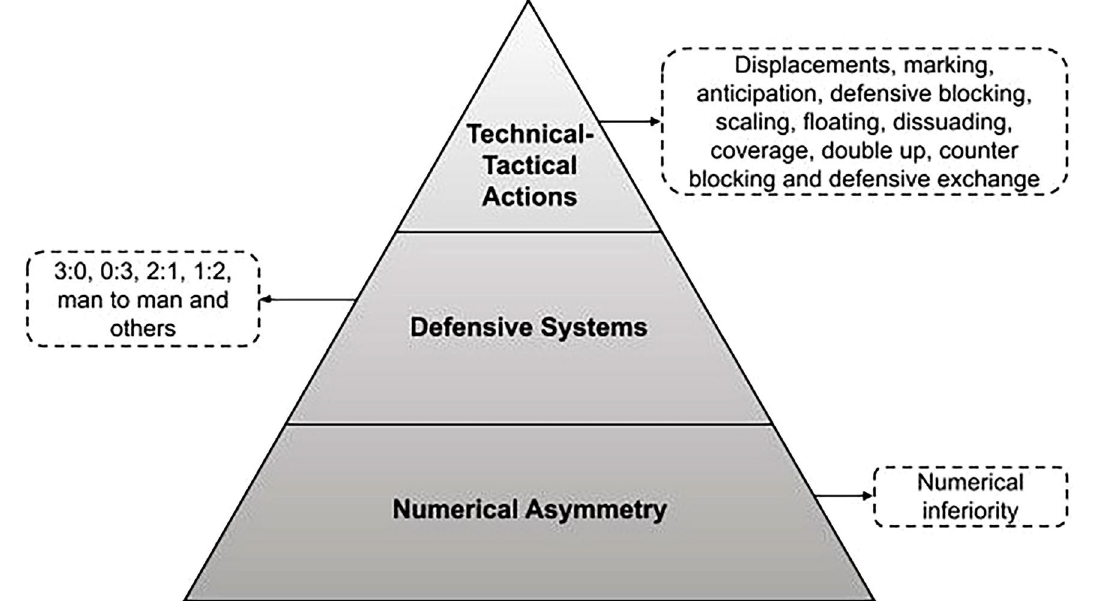
Figure 1 - The structuring elements of defensive phase in